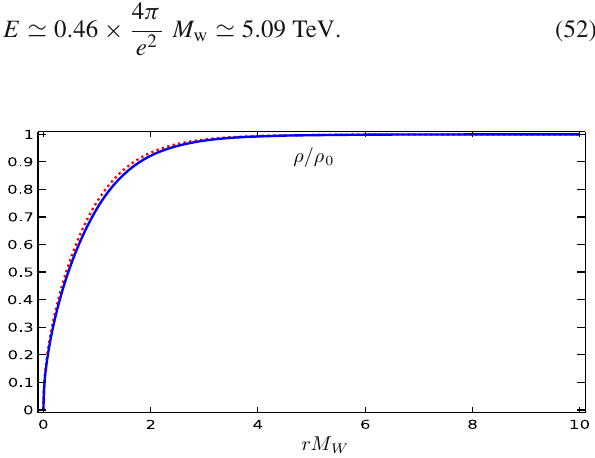
Fig. 8 The Higgs field dressings of the regularized monopole in the absence of the W boson. The blue curve corresponds to the real electro- magnetic permittivity ¯ (cid:14) = (ρ/ρ 0 ) 6 and the red curve corresponds to the hypercharge permittivity ˜ (cid:14) = (ρ/ρ 0 ) 6 . Exactly the same solution also describes the finite energy Dirac monopole regularized by the vacuum